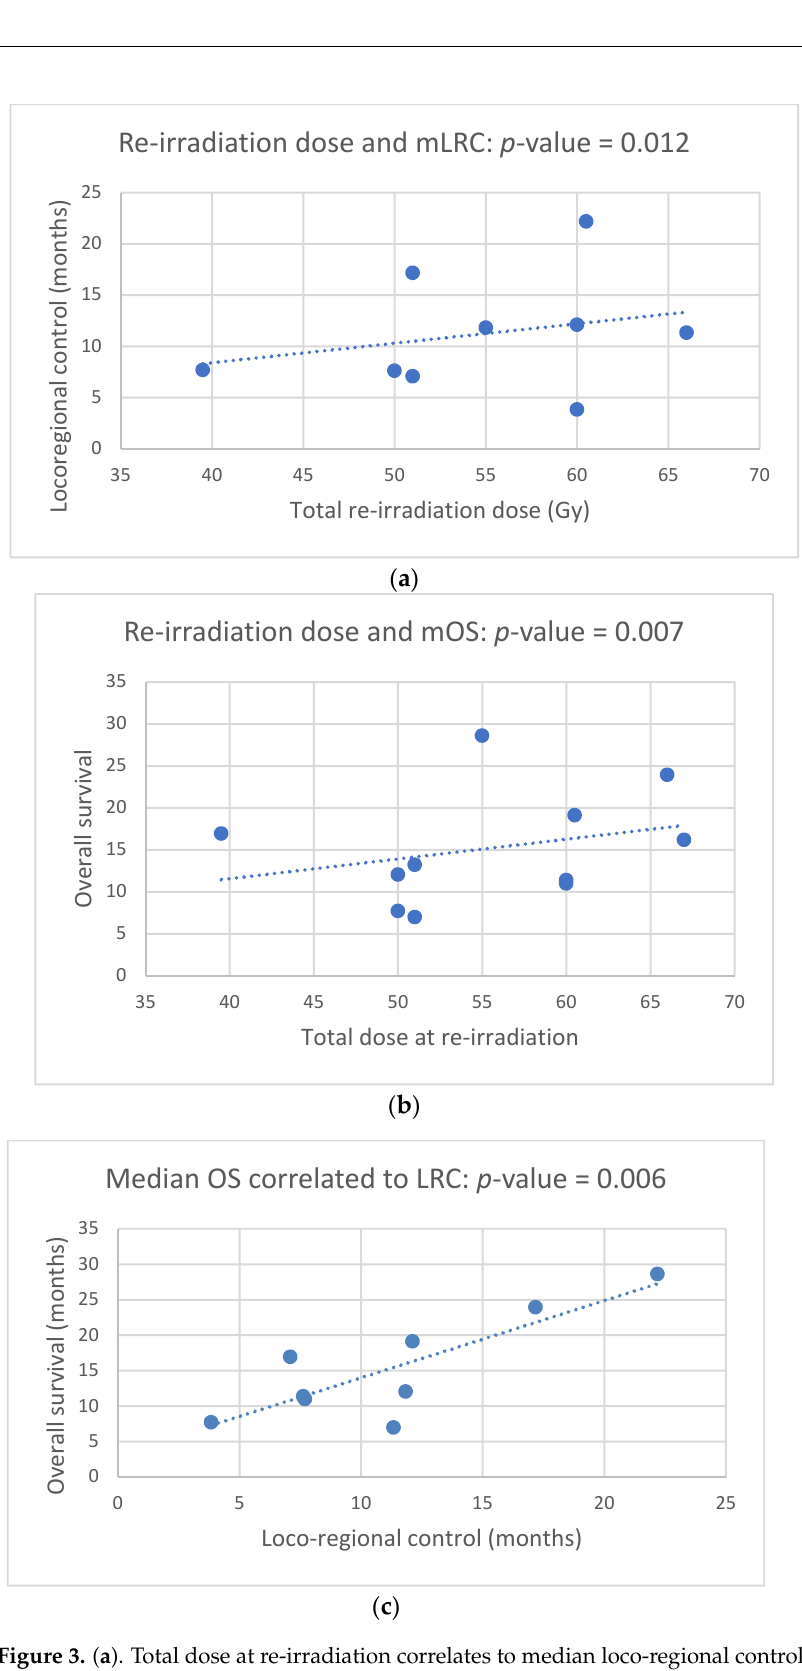
Figure 4. The occurrence of acute toxicity grade 1 to 4 versus PTV size at re-irradiation: patients who experienced acute toxicity grade 1 to 4 had a larger PTV compared with those without (Pearson correlation, p -value = 0.033). The studies by Kilburn and Ohguri could not be included in this calcu- lation since they did not contain information on PTV size, hence the number of patients was reduced to 458. 3.5.2. Chemo-Immunotherapy at Re-Irradiation Apart from the patients in the studies by Kilburn [25], Ohguri [23], and Chao [3], most patients received sequential CT at re-irradiation. Moreover, in two studies, 21/47 (45%) and 6/50 (12%) of the patients were additionally treated with immunotherapy, re- spectively [26,32]. The addition of one of the following ICIs to chemotherapy and re-irra- diation in the treatment of in-field thoracic recurrence has been associated with prolonged OS [32]: atezolizumab, pembrolizumab, nivolumab, or durvalumab [32]. The potential synergistic effect of radiation treatment and immunotherapy in relation to local and sys- temic anti-tumor response, which could possibly be responsible for the above-mentioned result, is currently a topic of intensive discussion. 4. Discussion